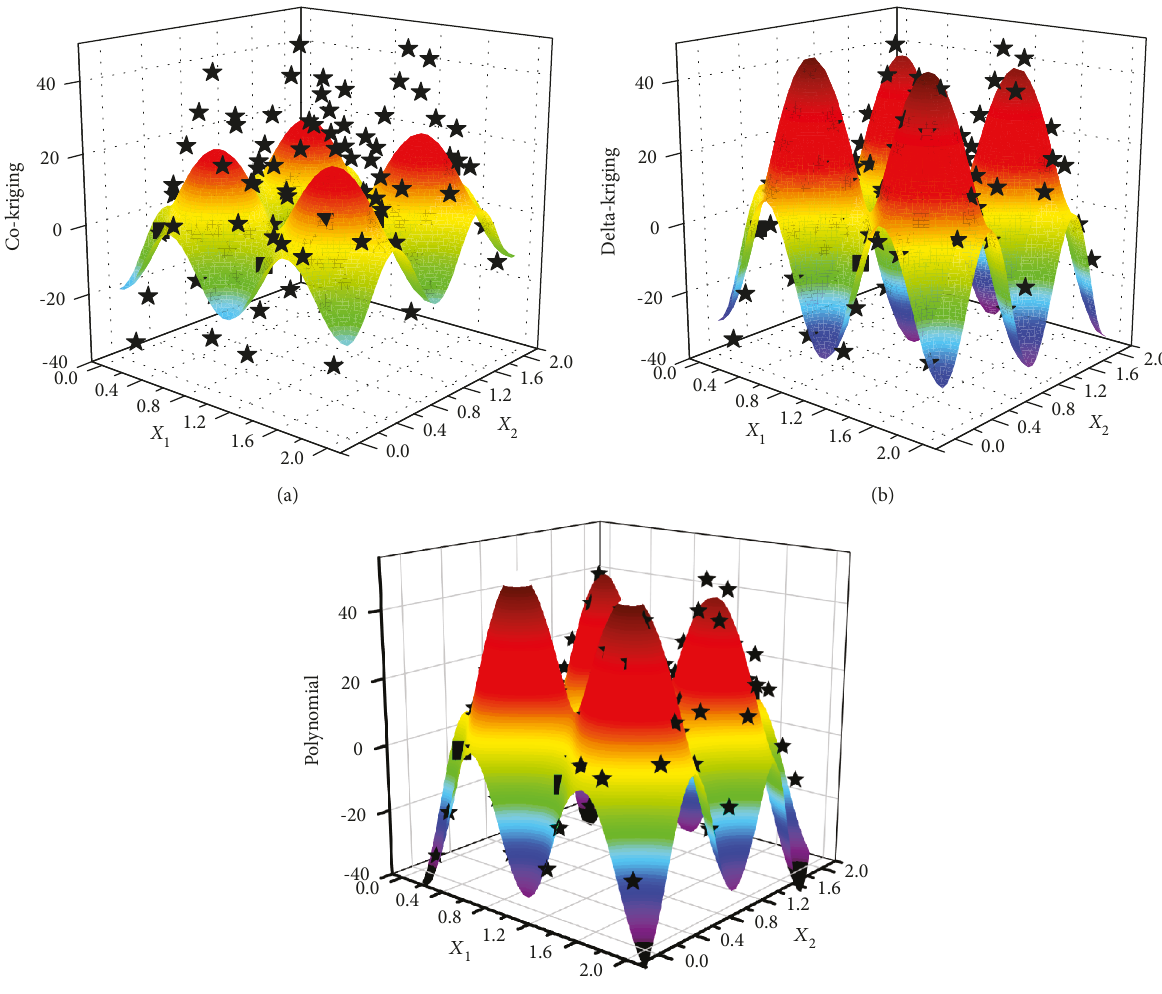
Figure 6: Results with 9 high LoF data points: (a) Co-Kriging method, (b) delta-Kriging method, and (c) polynomial